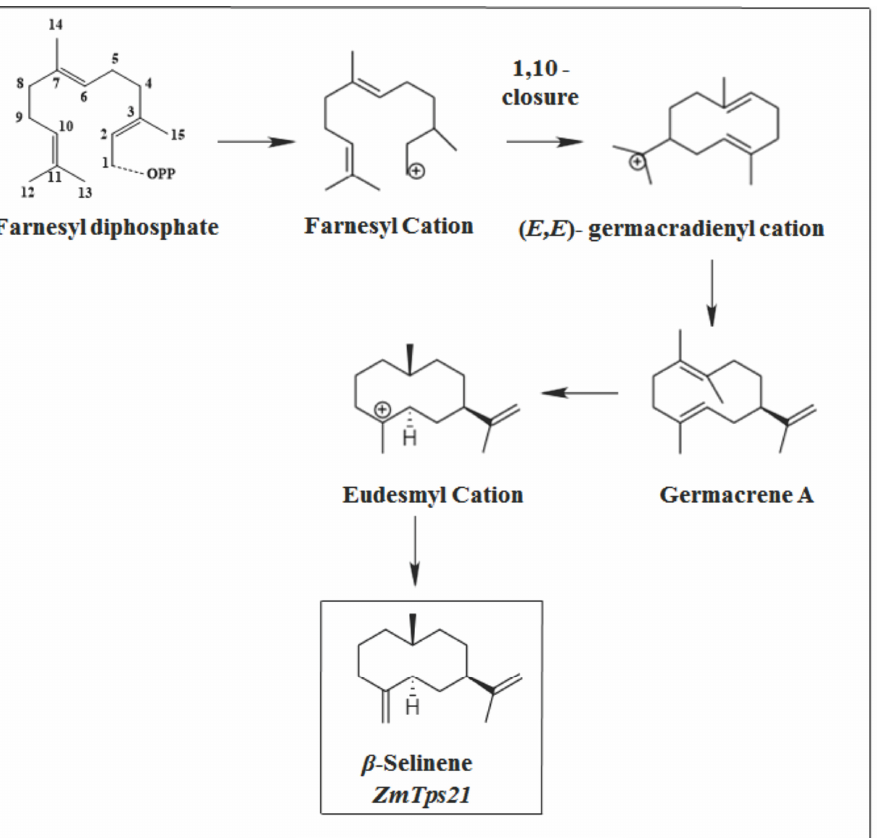
Figure 11. A type of primary cyclization of β -selinene.